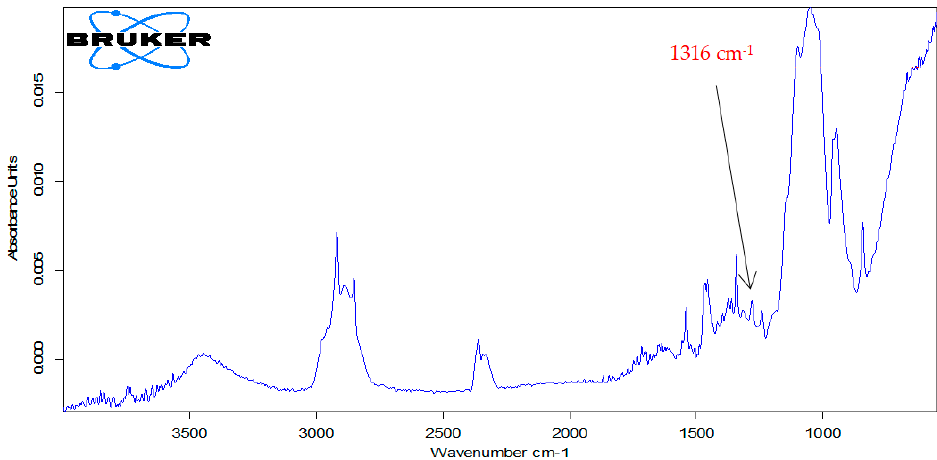
Figure 8. FTIR spectrum of Sortis 20 mg.